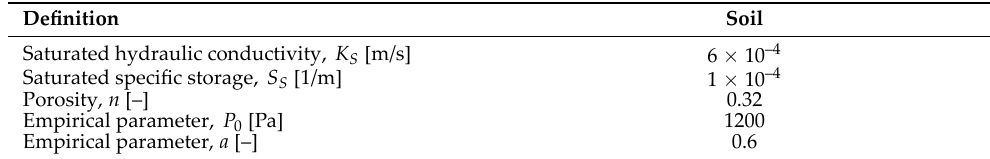
Table 1. Input parameters for the seepage model.